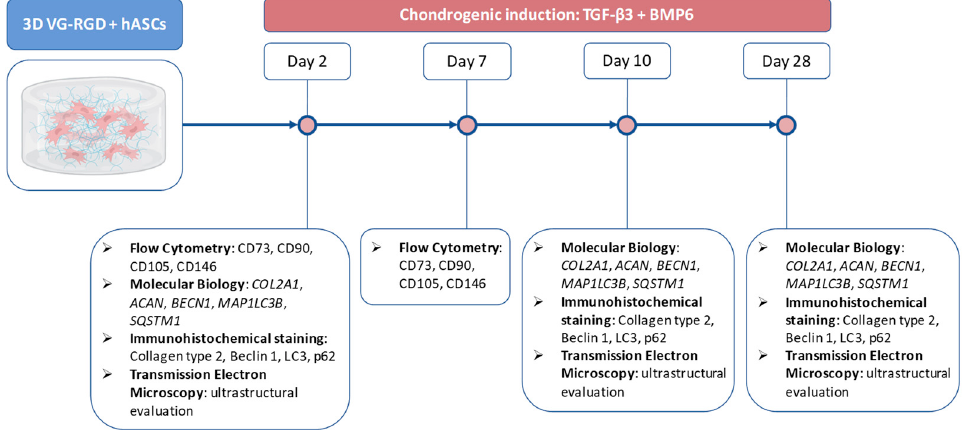
Figure 2. Experimental scheme.